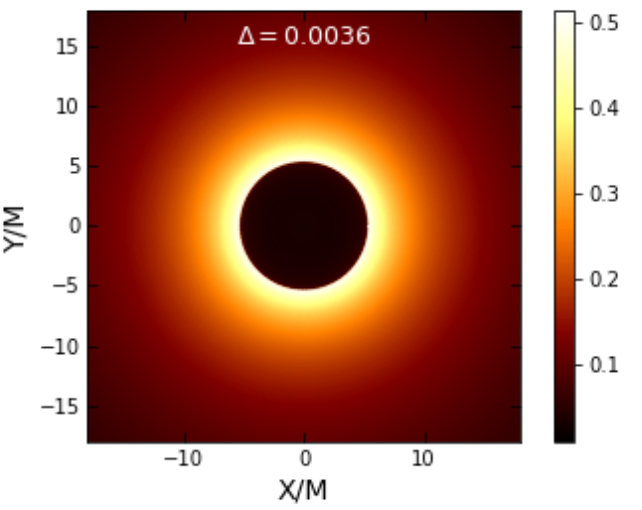
Figure 6. The shadow image and intensity for a black hole with Barrow entropy, for the best-fit values of (39) and Figure 5 arising from S2 star data with Monte-Carlo-Markov Chains